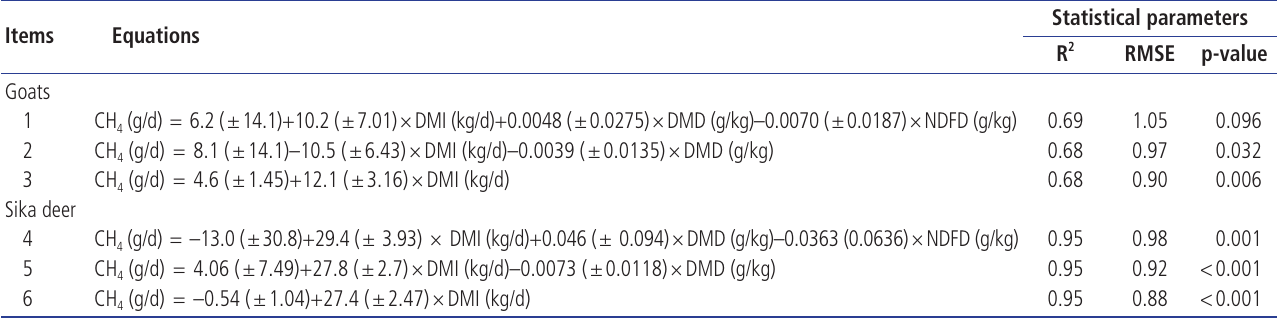
Table 4. Equations for enteric methane emission from goats (Capra hircus hircus) and Sika deer (Cervus nippon hortulorum) Items